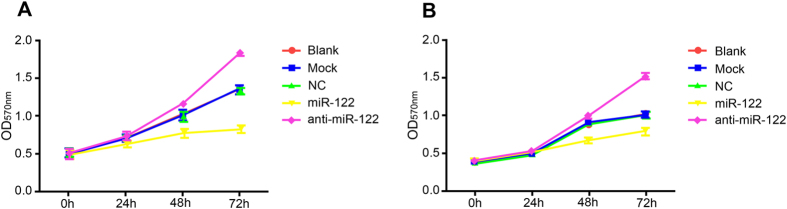
3-(4,5-dimethylthiazol-2-yl)-2,5- diphenyltetrazolium bromid (MTT) assay detected the role of microRNA-122 (miR-122) in inhibiting QBC939 and RBE cell proliferation, (A) QBC939 cells; (B) RBE cells. NC: negative control; OD, optical density.